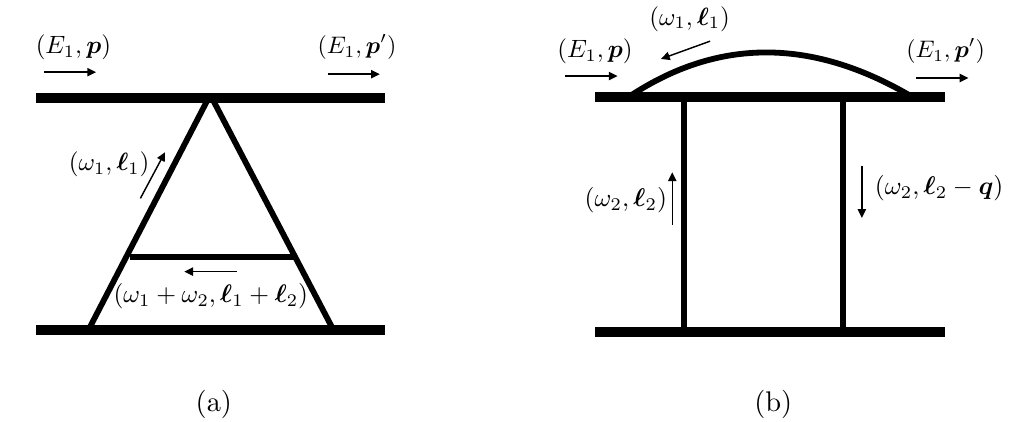
Figure 25 . Examples of diagrams that do not have classical potential